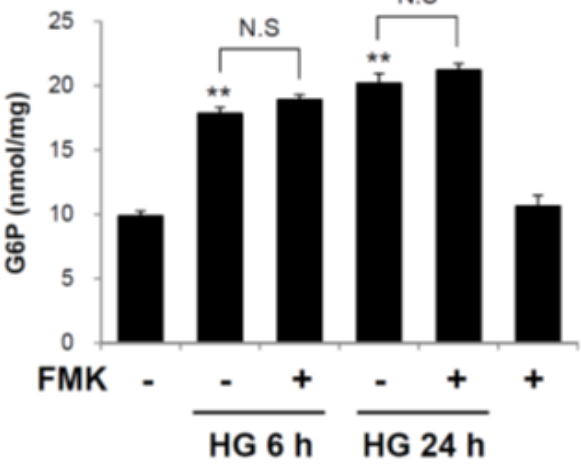
Figure 6. Glucose 6-phosphate was not involved in the inhibition of the HG-induced ChREBP activation by FMK. INS-1 cells were pretreated with FMK (20 µ M) for 1 h, and then incubated with high glucose (HG, 25 mM) for 6 or 24 h. Intracellular concentrations of glucose 6-phosphate (G6P) were measured using a G6P colorimetric assay Kit. Results are presented as bar graphs and are the means ± SDs of three independent experiments. ** p < 0.05 vs. non-treated controls; N.S., not significant.